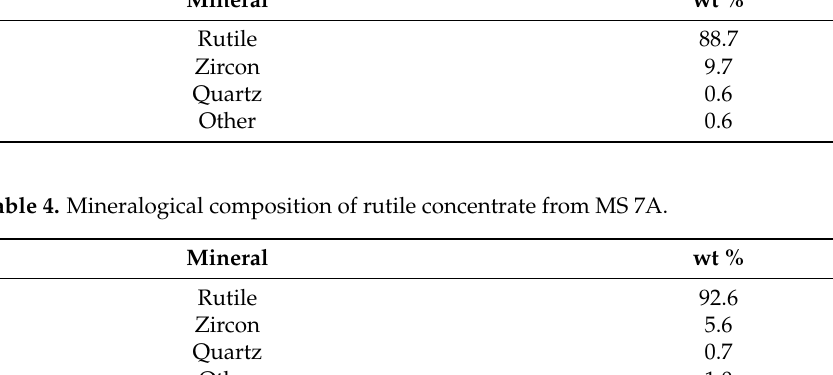
Table 4. Mineralogical composition of rutile concentrate from MS 7A.